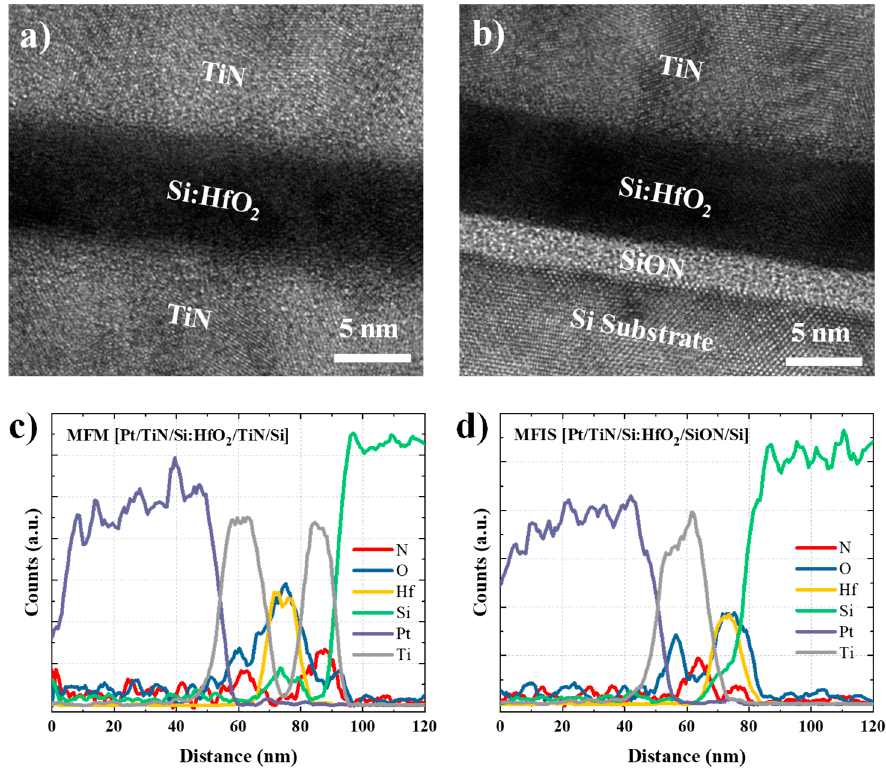
Figure 1. The TEM data for ( a ) MFM and ( b ) MFIS FTJ devices; elemental depth profiles of ( c ) MFM and ( d ) MFIS stacks analyzed by EDS.